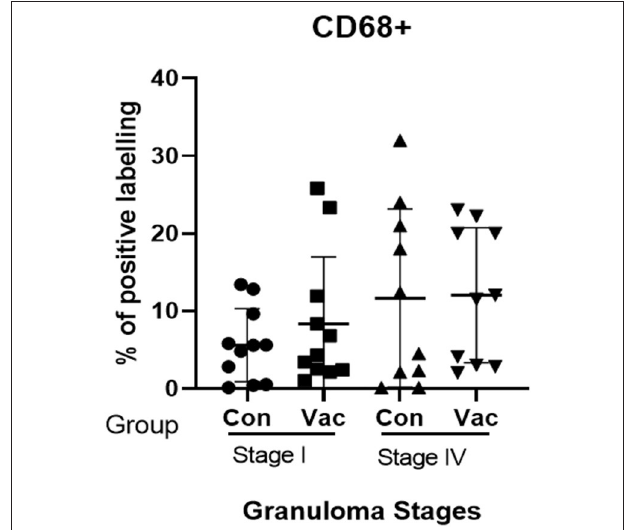
FIGURE 3 | Immunolabelling for CD68 + cells. Comparison of CD68 + cell distribution in granuloma stages I and IV of BCG vaccinated (Vac) and non-vaccinated (Con)